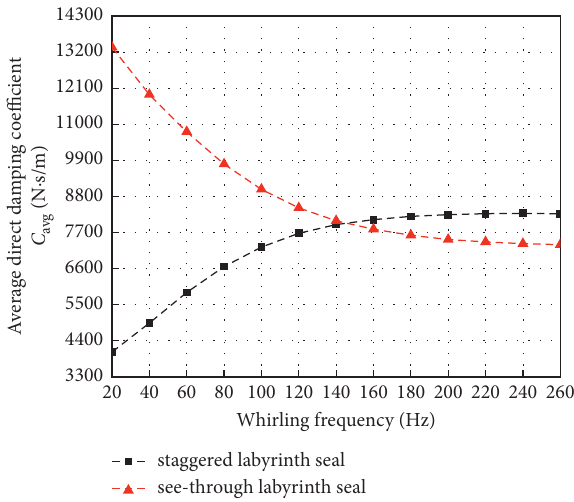
Figure 30: Average direct damping coefficient vs. whirling frequency.